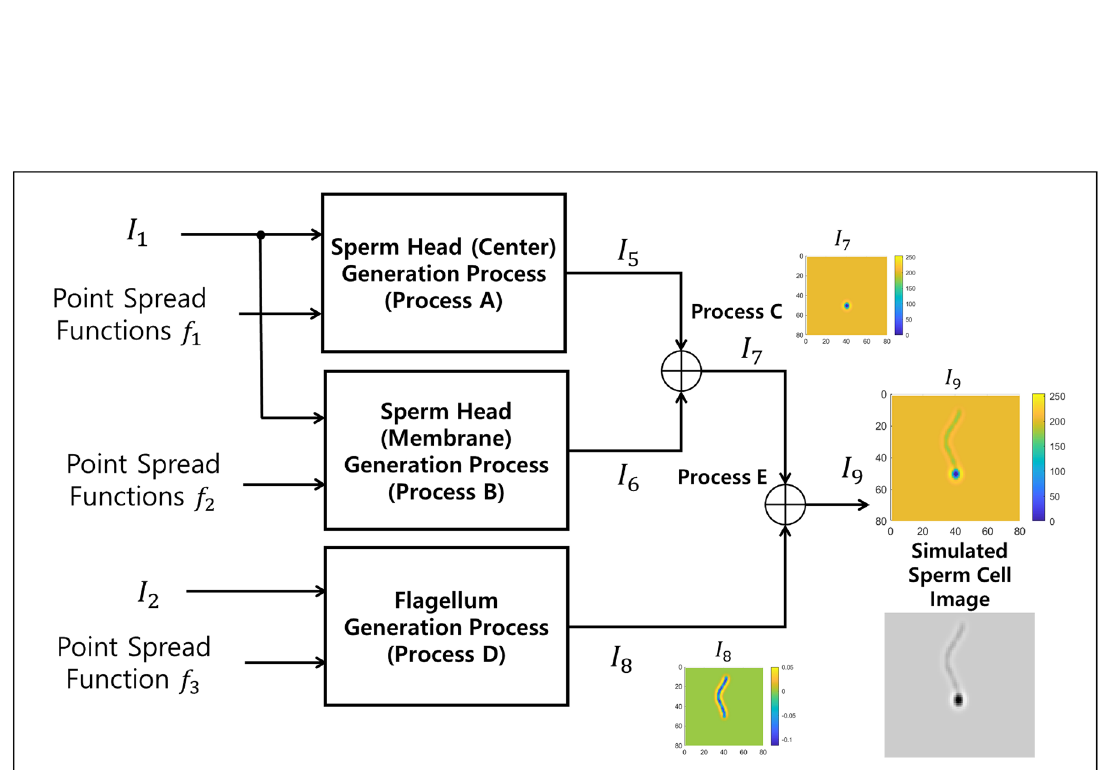
Figure 3. Flowchart of sperm image generation process. Image I 1 and I 2 , and point spread functions f 1 , f 2 , and f 3 are the inputs. The output I 9 is the simulated sperm image. Details of each process are shown in Figs. 5, 7, 8, 9, and 10. Image I 7 shows the image of sperm head (Output of process C). Image I 8 shows the image of flagellum (Output of process D). Image I 9 shows the image of sperm head (Output of process E). Color bars next to I 7 - I 9 indicate the corresponding grayscale intensity values. Resulting grayscale image of simulated sperm cell below the colored plot of I 9